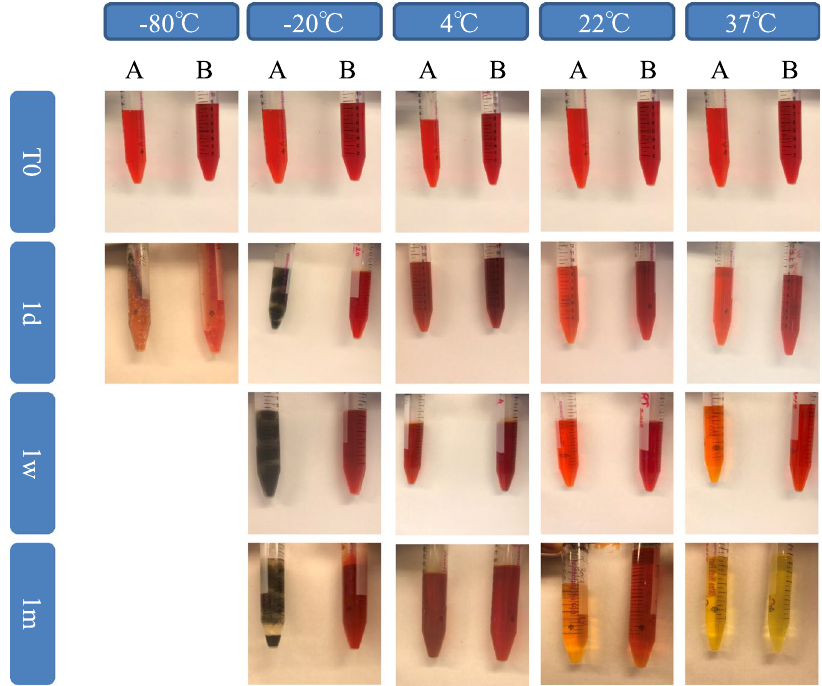
Figure 1. Solutions of iDTZ show improved stability under various temperatures and lengths of time. Solutions were prepared as described using standard DTZ ( A ) and iDTZ ( B ) and exposed to a range of temperatures and storage intervals ( − 80°, − 20°, 4 °C, and 22 °C and 1, 7, and 30